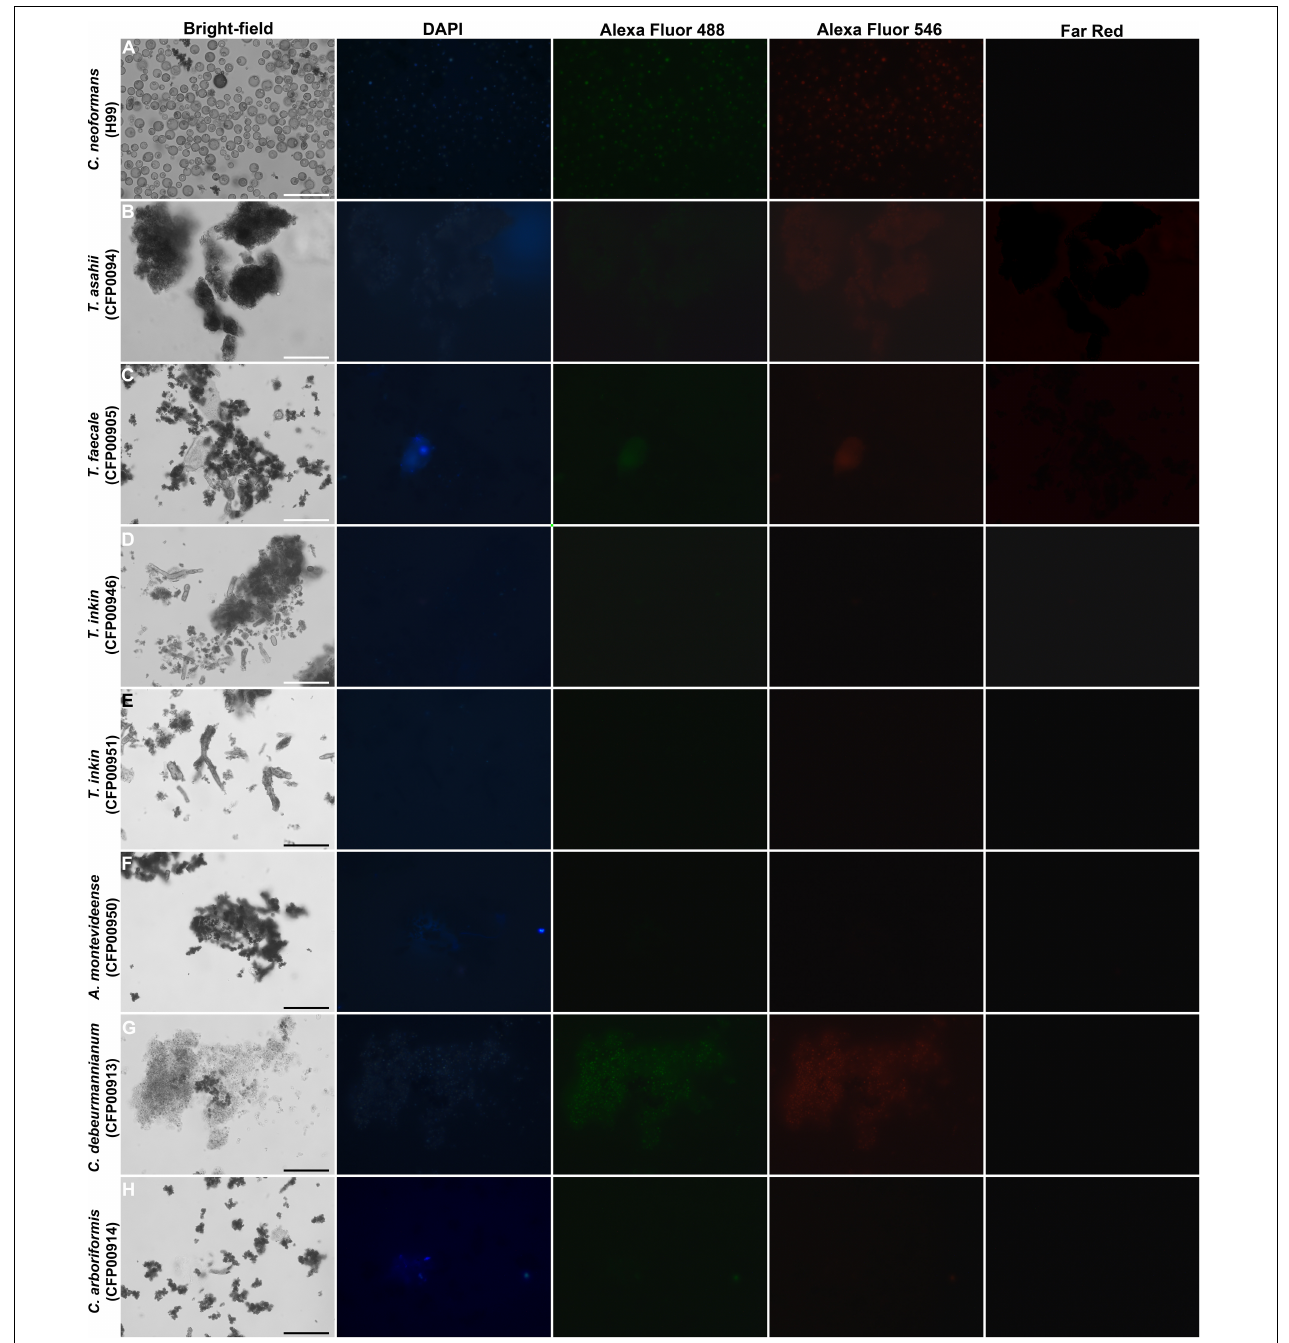
FIGURE 5 | Fluorescence of particles recovered after HCl treatment from Trichosporonaceae cells grown in minimal medium supplemented with 1 mM of L-DOPA, shown by bright-field, fluorescence under a DAPI (4 (cid:48) ,6 (cid:48) -diamidino-2-phenylindole), Alexa Fluor 488, Alexa Fluor 546, and Far-Red filters. Bar = 30 µ m. (A) Cryptococcus neoformans H99, (B) Trichosporon asahii CFP00944, (C) Trichosporon faecale CFP00905, (D) Trichosporon inkin CFP00946, (E) Trichosporon inkin CFP00951, (F) Apiotrichum montevideense CFP00950, (G) Cutaneotrichosporon debeurmannianum CFP00913, (H) Cutaneotrichosporon arboriformis